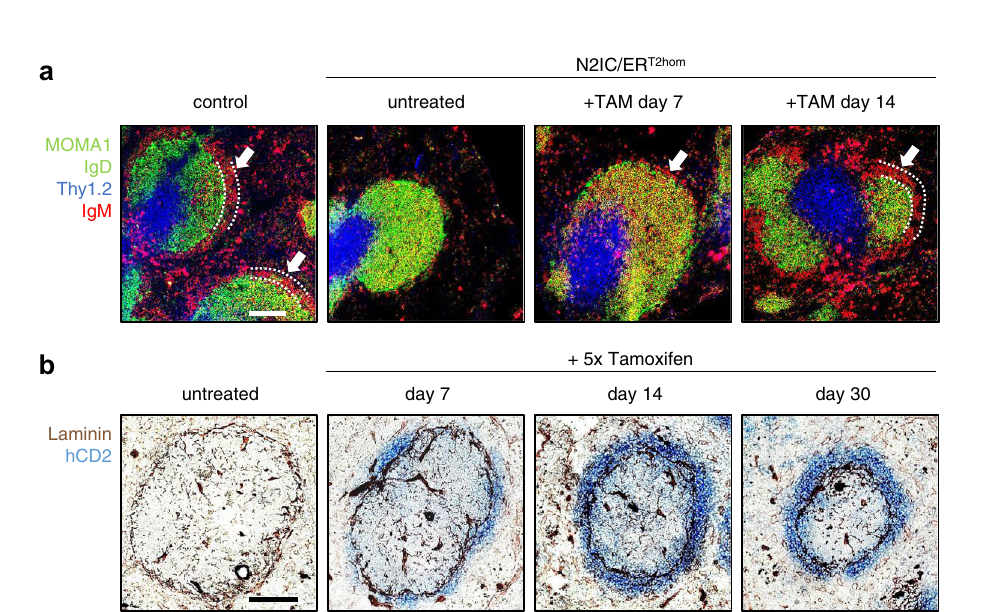
dependency of MZB cell development.